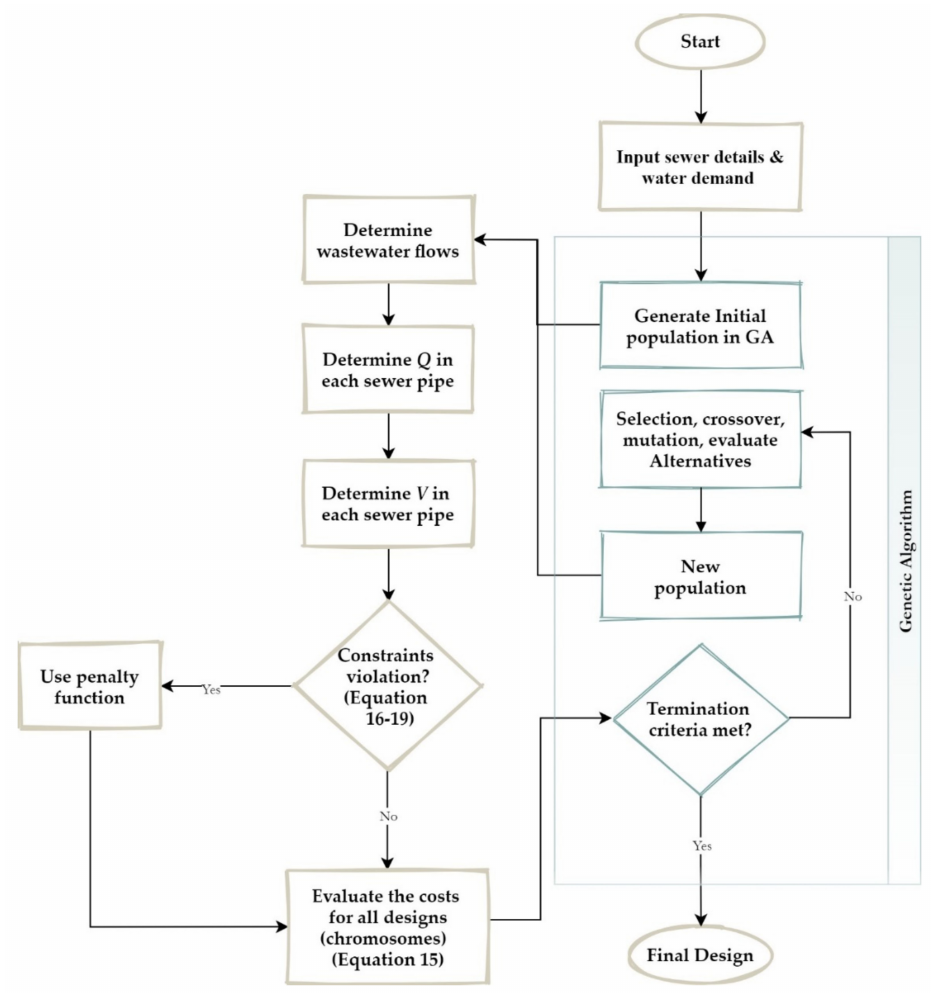
Figure 4. The proposed simulation–optimization